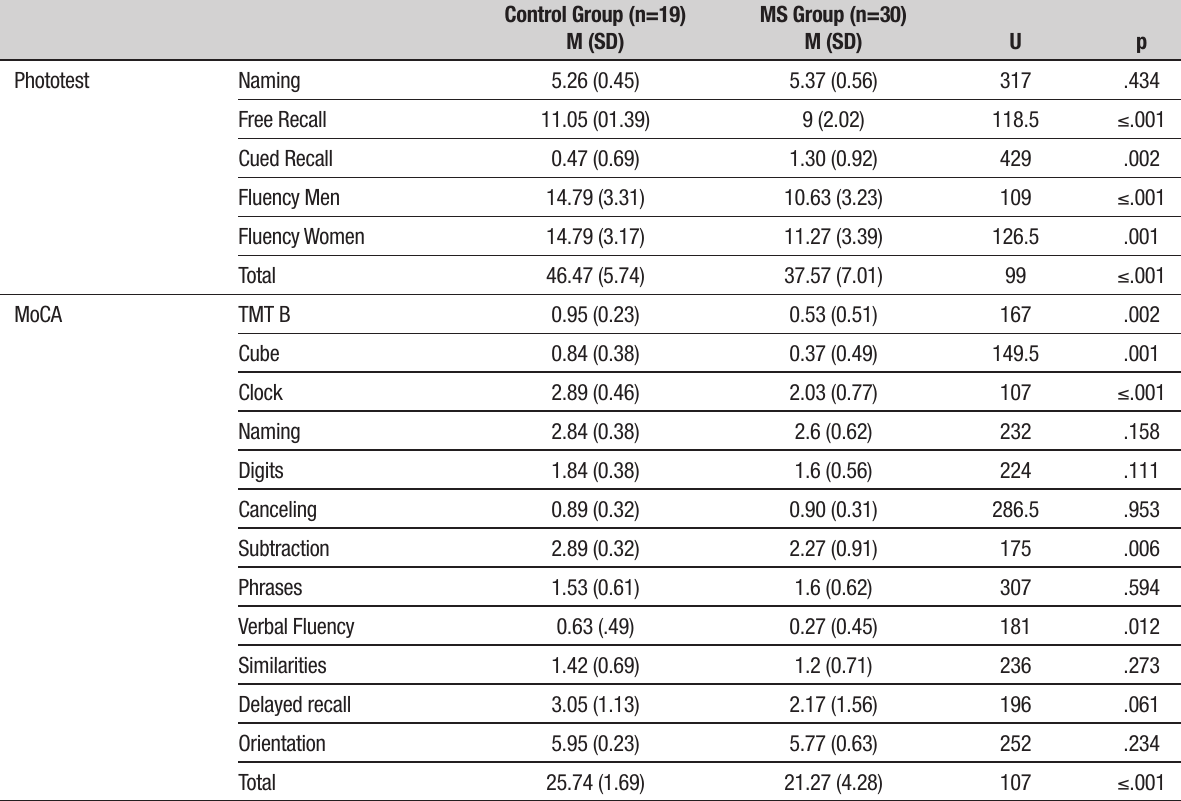
Table 2. Comparison of results obtained by the two groups on neuropsychological